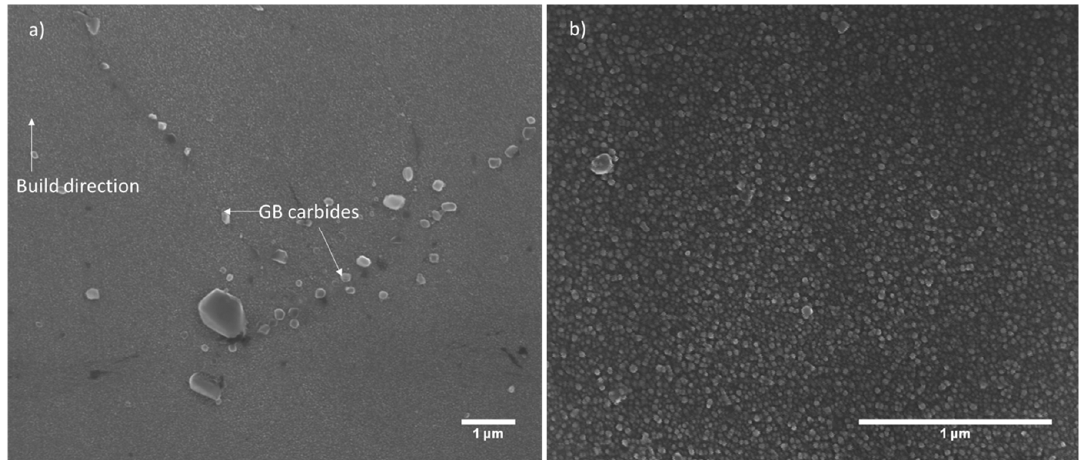
Figure 5. ( a ) SEM image of microstructure after hot isostatic pressing (HIP) showing grain boundary carbides, ( b ) SEM image taken at a higher magnification to show γ ’ precipitation after HIP treatment.